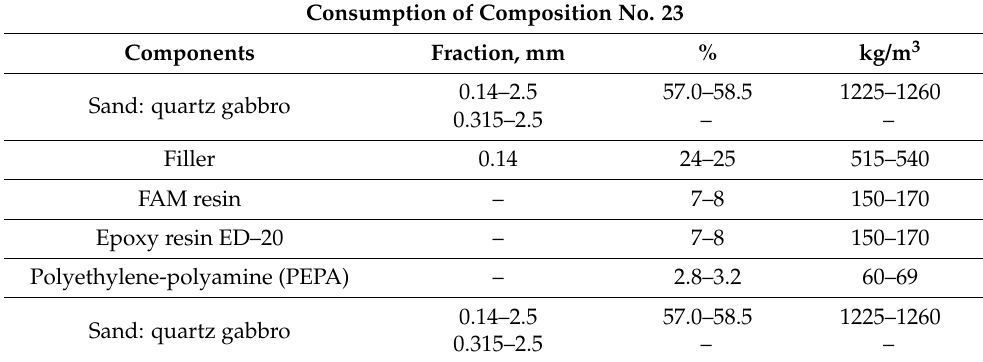
Table 2. Polymer-concrete composition No.